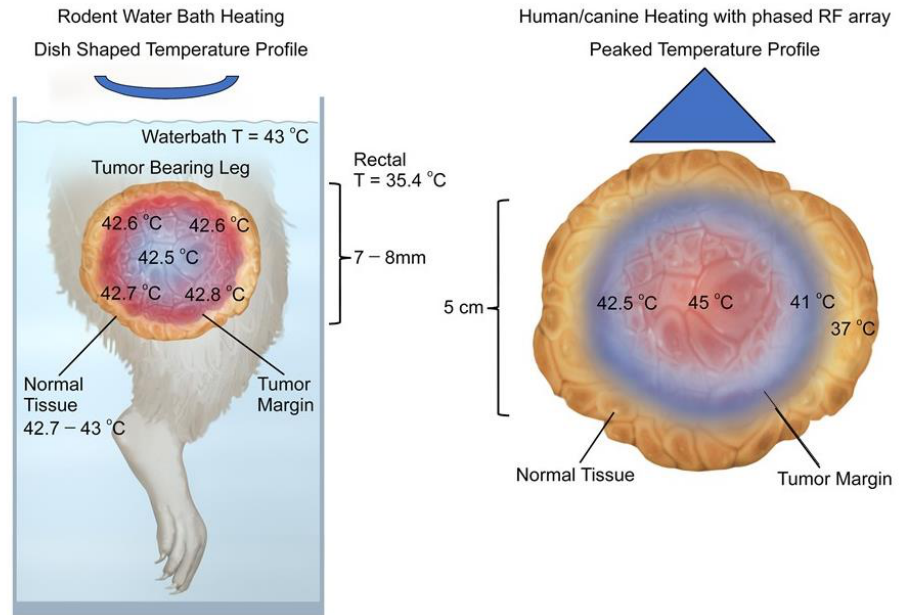
Figure 1. Schematic comparison of temperature distributions for rodent water bath heating vs. temperatures seen in canine and human tumors heated with radiofrequency or microwave devices. ( Left Panel ) Temperature distributions in rodent tumors heated with water baths tend to be relatively uniform [profiles are dish-shaped], with highest temperatures at the margin of the tumor, while intra-tumoral temperatures are slightly cooler and relatively uniform. Depicted data are taken from a paper by O’Hara et al., where deta iled intra-tumoral temperatures were documented using micro-thermocouples [72]. Although not shown in color for clarity, the whole leg is at elevated temperature. This is described numerically at the left side of the figure. ( Right Panel ) Temperature distributions in human and canine sarcomas heated with phased radiofrequency devices have a peaked temperature distribution in which the temperatures closer to the center are higher than those at the tumor edge. Typically, some surrounding normal tissue is heated to mild temperatures, as depicted. Note also that maximum intra-tumoral temperatures are higher than what is seen in rodent tumors. This is a schematic representation of non-invasive thermometry obtained in human sarcomas [79 – 81]. 3.2. Thermometry in Human Tumors Is Mainly Acquired from Implanted Thermal Probes Since temperatures in human tumors are heterogeneous, thermometry is essential to assess the therapeutic value of a treatment. The vast majority of clinical thermal data to date has been derived from direct intra-tumoral measurements. Typically, one to two catheters are placed into the tumor and temperatures are measured as thermometers are pushed back and forth within the catheter [82]. The resultant data are depicted by descriptors of the temperature distribution, such as T 90 [10th percentile of distribution], T 50 [distribution median] or T 10 [90th percentile] [82]. Descriptors of the temperature distribution do not reveal anything about the spatial distribution of temperature, but rather provide an overall summary for the tumor as a whole. Non-invasive thermometry can provide spatially encoded thermal data, and this method has been implemented in some patients [78,81,82]. In the future, combinations of non-invasive thermometry with imaging of physiologic response may reveal whether intra-tumoral heterogeneity of physiologic response in tumors is dictated by local temperature variation. 4. Effects of Hyperthermia on Tumor Metabolism It has been reported previously that enzyme activity increases with temperature and time of heating until the point where enzyme denaturation occurs [83]. These effects are observed during heating and could influence oxygenation during HT. However, effects